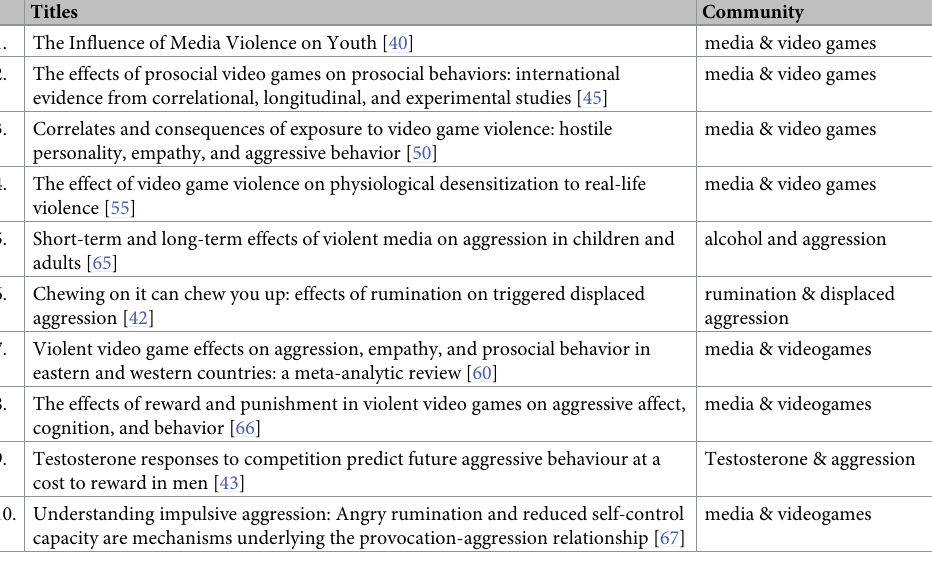
Table 4. The Top 10 most relevant papers (excluding the source paper) in our aggression network. For the top 11- 20 see the Section A in S1